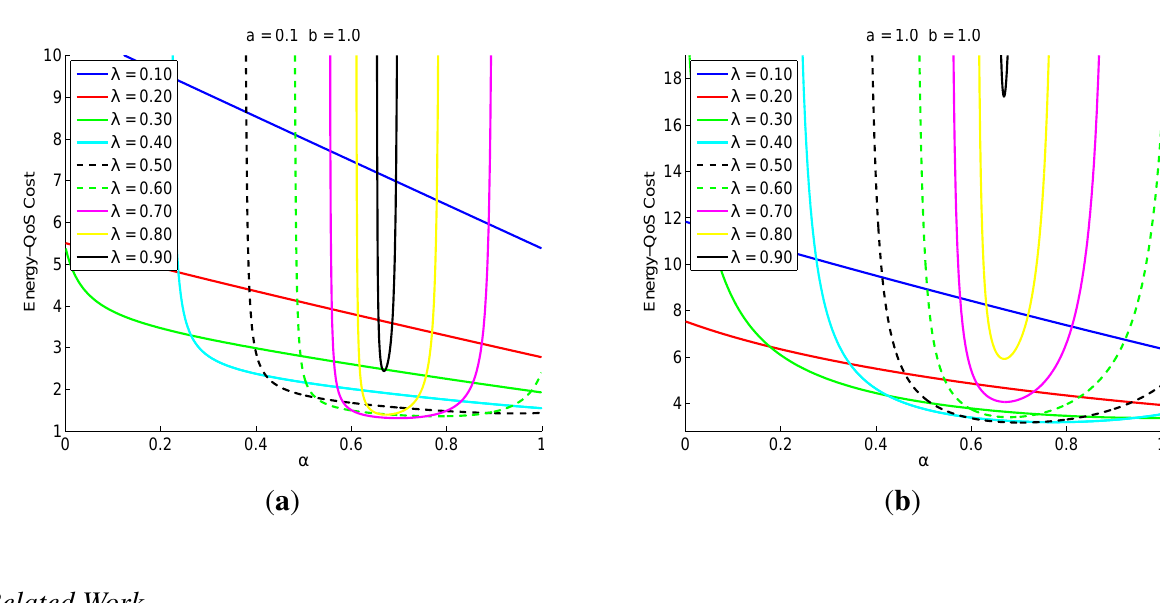
Figure 7. Energy–QoS cost vs . α . ( a ) a = 0 . 1 and b = 1 . 0 ; ( b ) a = b = 1 . 0